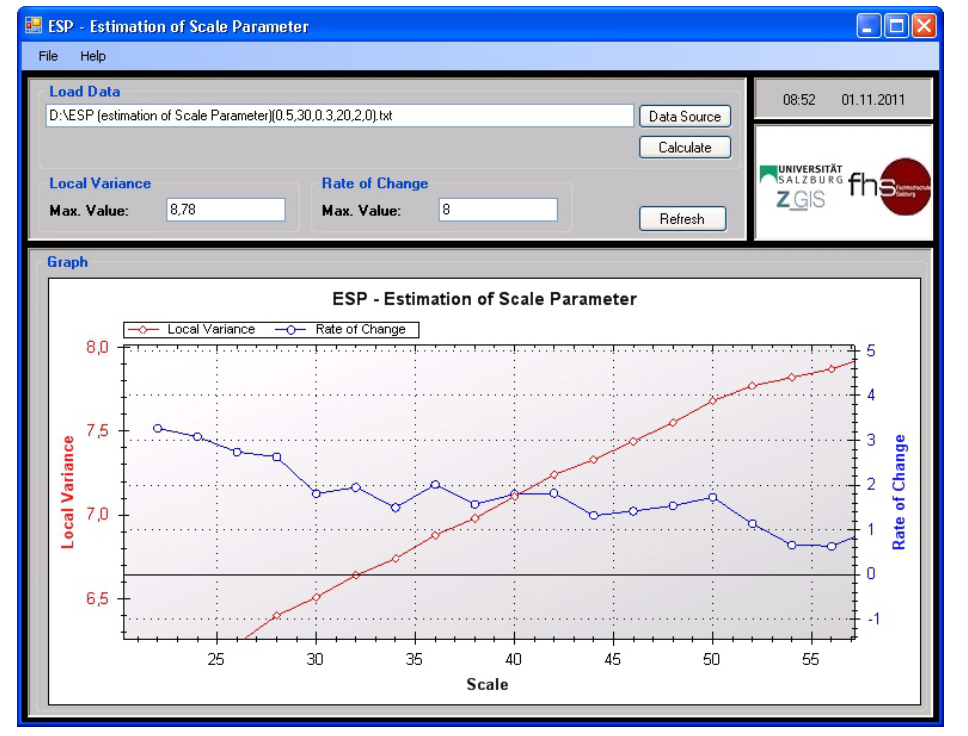
Figure 4. Results of the estimation of scale parameter (ESP) analysis showing potential scales for image segmentation. The peaks in the Rate of Change graph indicate object levels at which the image can be segmented in an appropriate manner (here a scale parameter of 36 was found